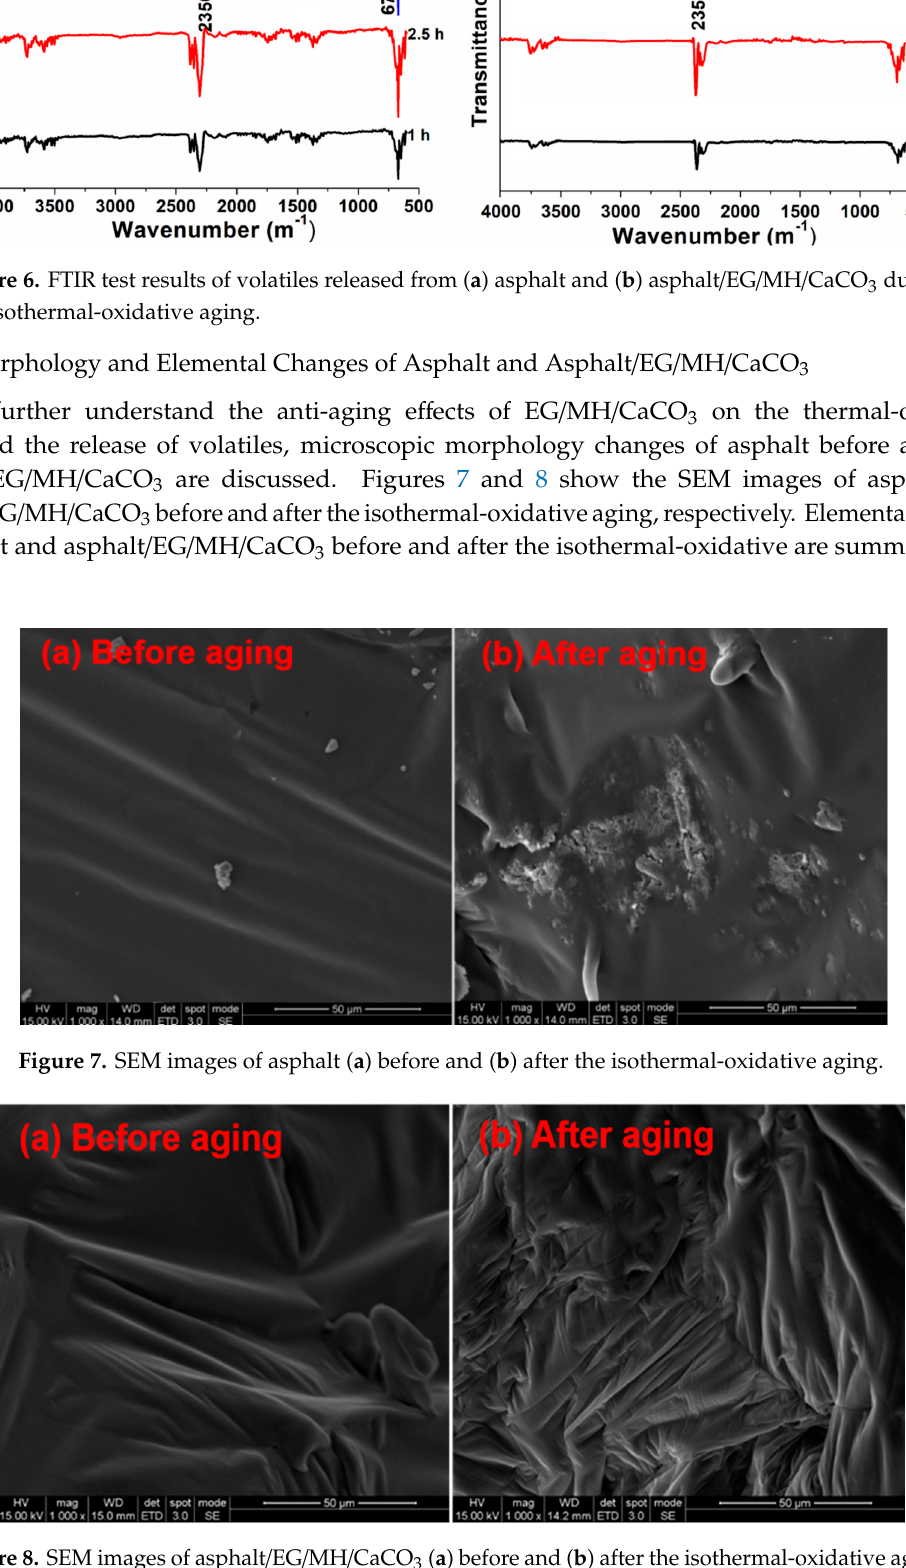
Figure 8. SEM images of asphalt/EG/MH/CaCO 3 ( a ) before and ( b ) after the isothermal-oxidative Table 2. Elemental content changes of asphalt and asphalt/EG/MH/CaCO 3 before and after the isothermal-oxidative aging.